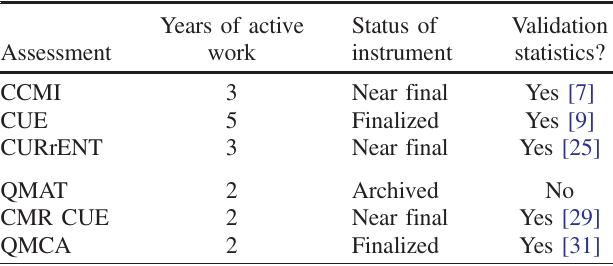
TABLE II. Status of the development and validation of CU ’ s upper-division assessments. The bottom two assessments are newly developed multiple-response and multiple-choice adapta- tions of the CUE and